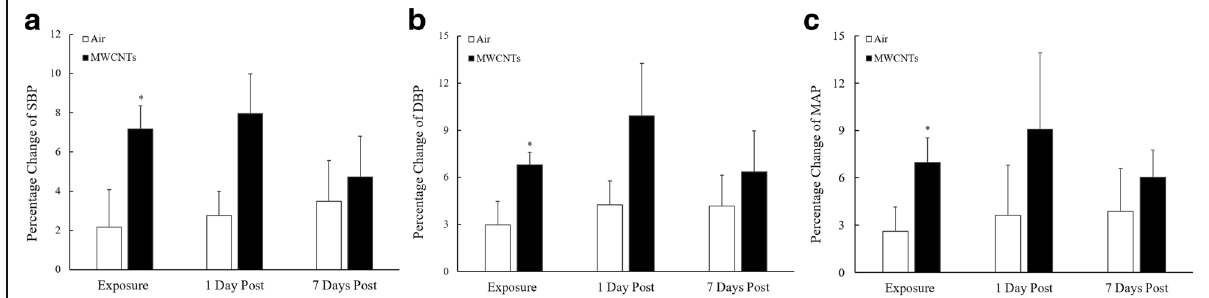
Fig. 2 a Bar graph depicting a percentage change of systolic blood pressure (SBP) during the exposure period and at 1 and 7 days after exposure from the basal level before exposure (pre-exposure control vs MWCNTs: 127.0 ± 3.0 vs 127.6 ± 1.7 mmHg). b Bar graph depicting a percentage change of diastolic blood pressure (DBP) during the exposure period and at 1 and 7 days after exposure from the basal level before exposure (pre-exposure control vs MWCNTs: 85.1 ± 2.0 vs 86.9 ± 1.2 mmHg). c Bar graph depicting a percentage change of mean blood pressure (MAP) during the exposure period and at 1 and 7 days after exposure from the basal level before exposure (pre-exposure control vs MWCNTs: 99.1 ± 2.3 vs 100.4 ± 1.4 mmHg). Each value represents the mean ± SE of eight rats. P < 0.01 compared with control group